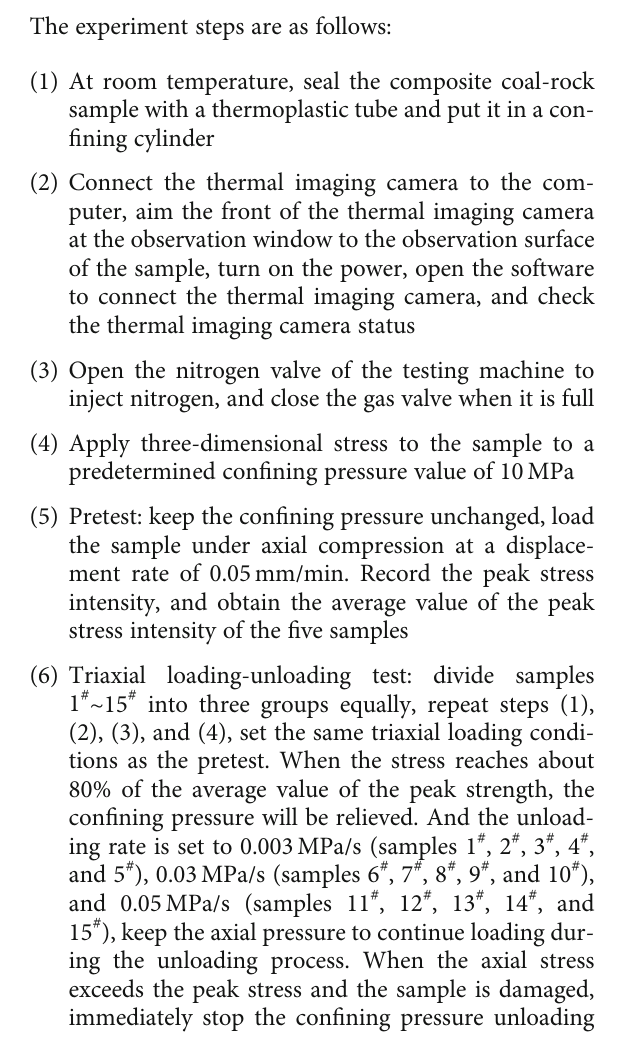
Table 3: Comparison of T ave and peak stress parameters of coal body under di